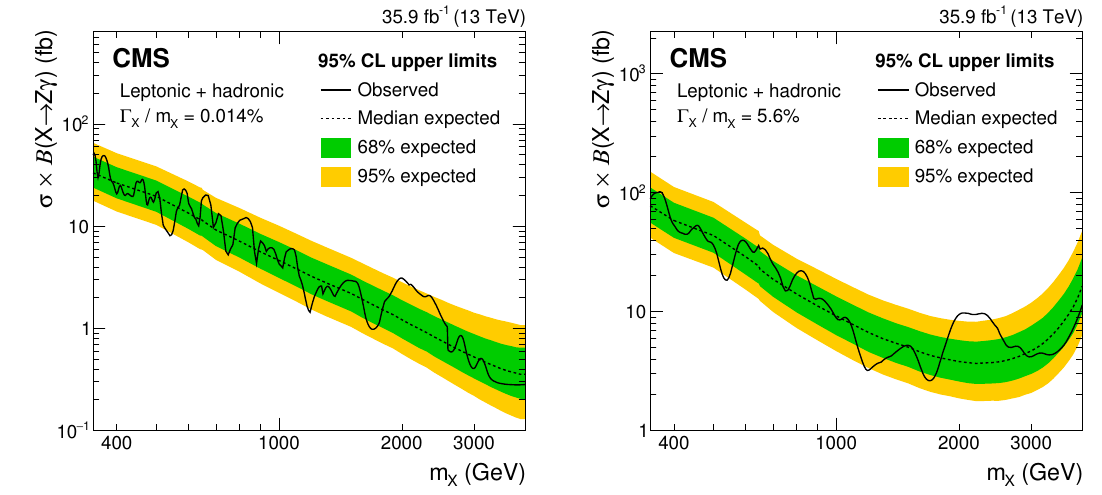
Figure 7 . Observed and expected limits on the product of the production cross section and branching fraction B (X ! Z (cid:13) ), as a function of signal mass m X , for (left) narrow and (right) broad spin-0 resonances, obtained from the combination of the leptonic and hadronic decay